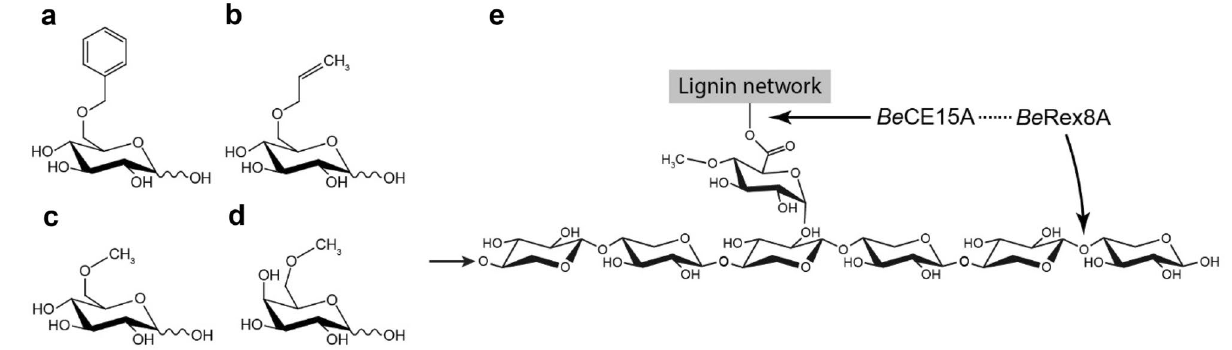
Figure 3. Substrates used to assay glucuronoyl esterase activity of Be CE15A: (a) benzyl glucuronoate, (b) allyl glucuronoate, (c) methyl glucuronoate, and (d) methyl galacturonoate. (e) The suggested target of the full-length Be CE15A-Rex8A enzyme, consists of a xylooligosaccharide (or longer xylan chain as indicated by the small arrow) decorated with GlcA, which is further ester-linked to lignin or lignin fragments.